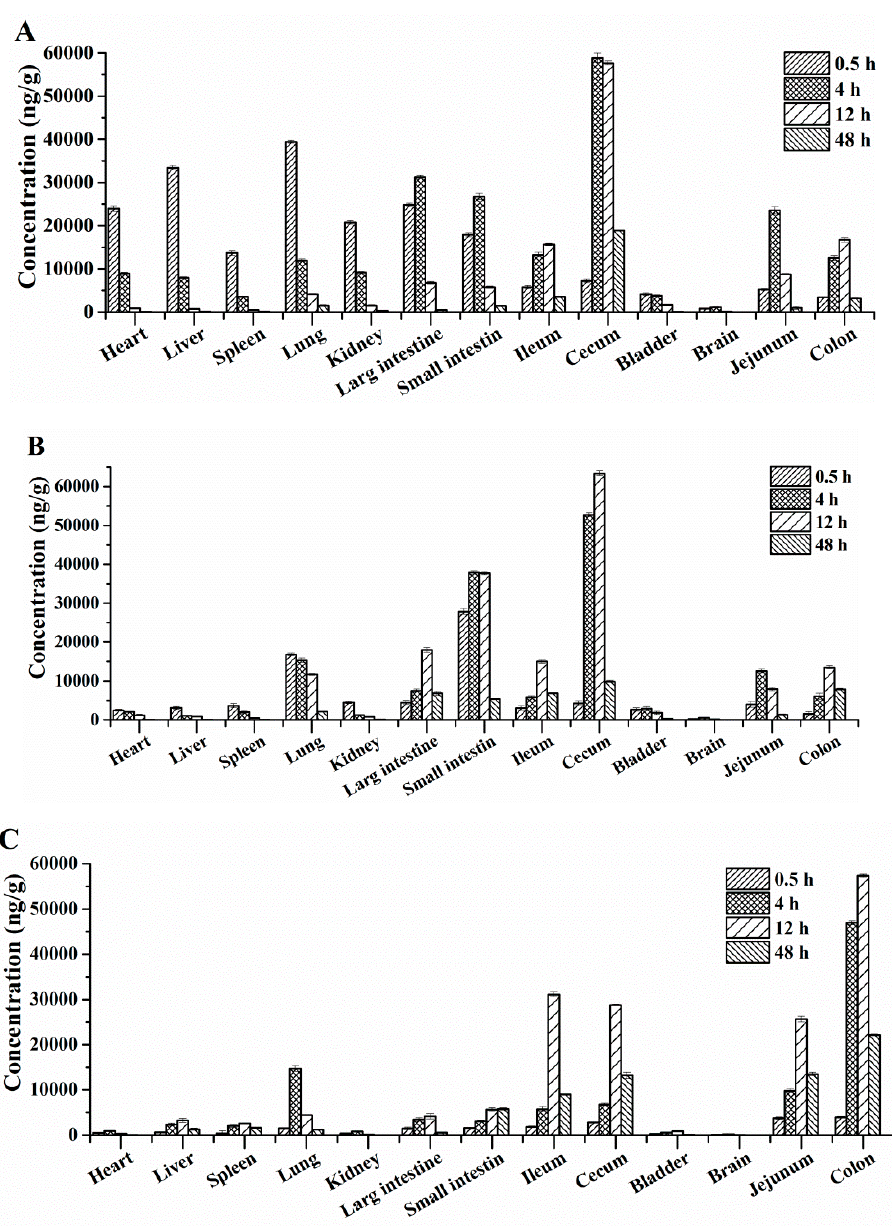
Figure 4. Mean concentration of DPTM in various tissues at 0.5, 4, 12 and 48 h after i.v. ( A ), i.m. ( B ) and p.o. ( C ) administration at a dose of 75 mg/kg ( n = 12, mean ± SD).